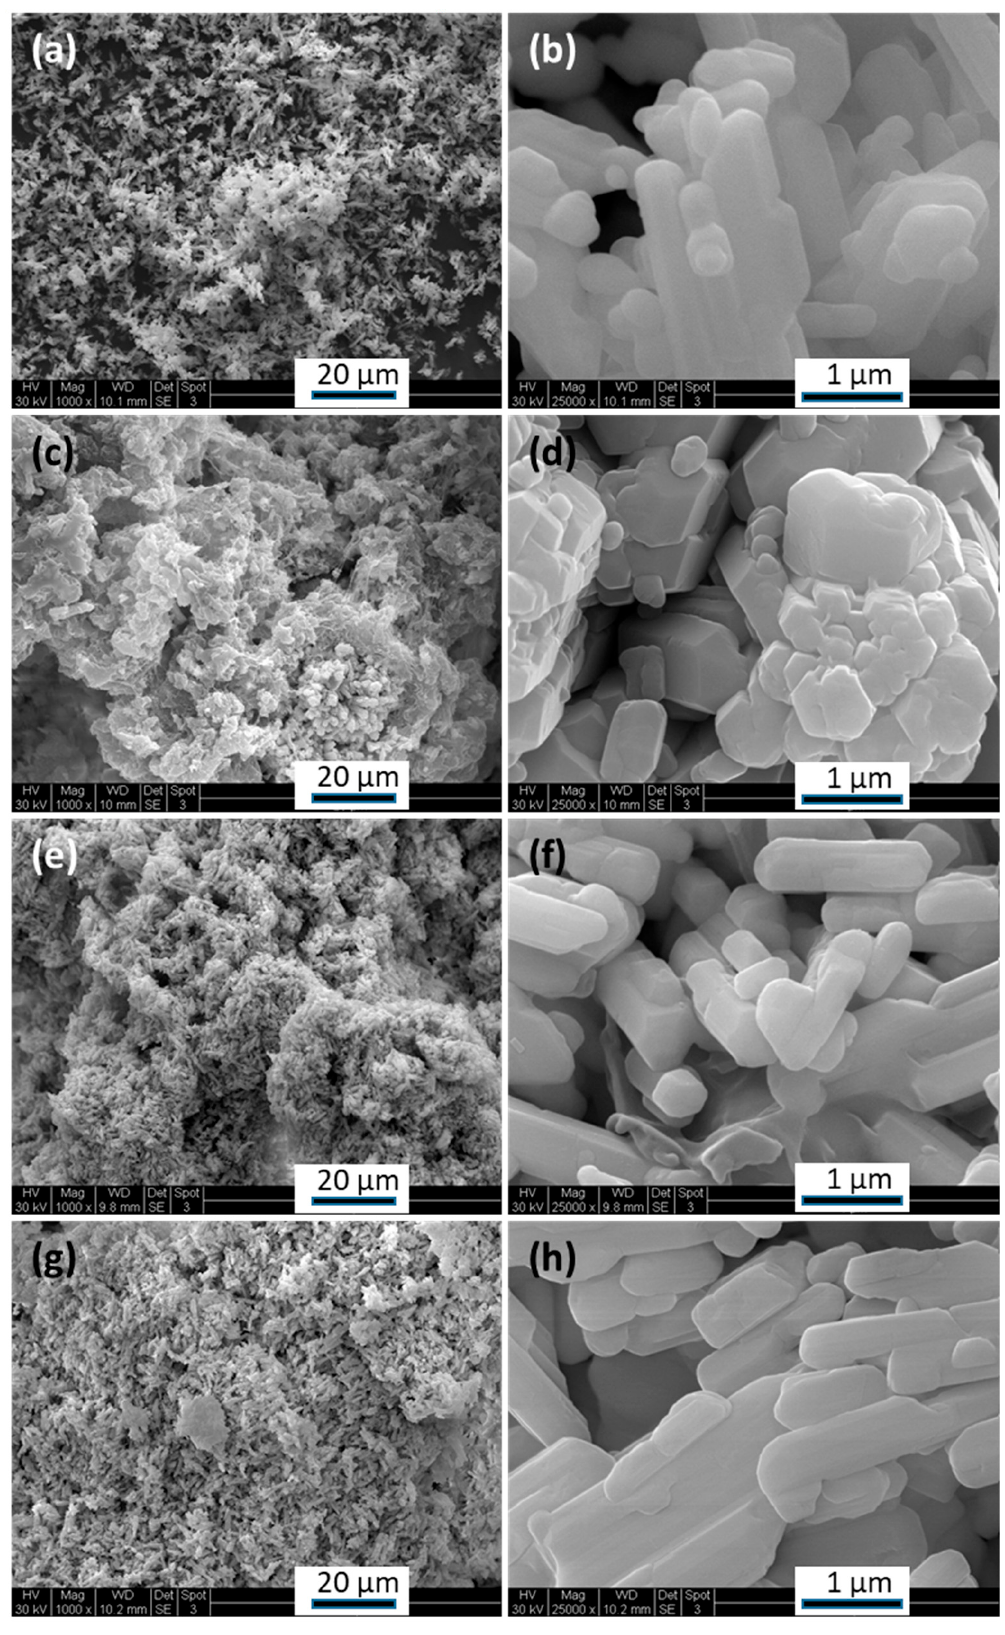
Figure 2. SEM images of control BaCO 3 ( a ) and ( b ), and PCL/Ba samples; (50/50) ( c ) and ( d ), (10/90) ( e ) and ( f ), and (2.5/97.5) ( g ) and ( h ) at low and high resolution.